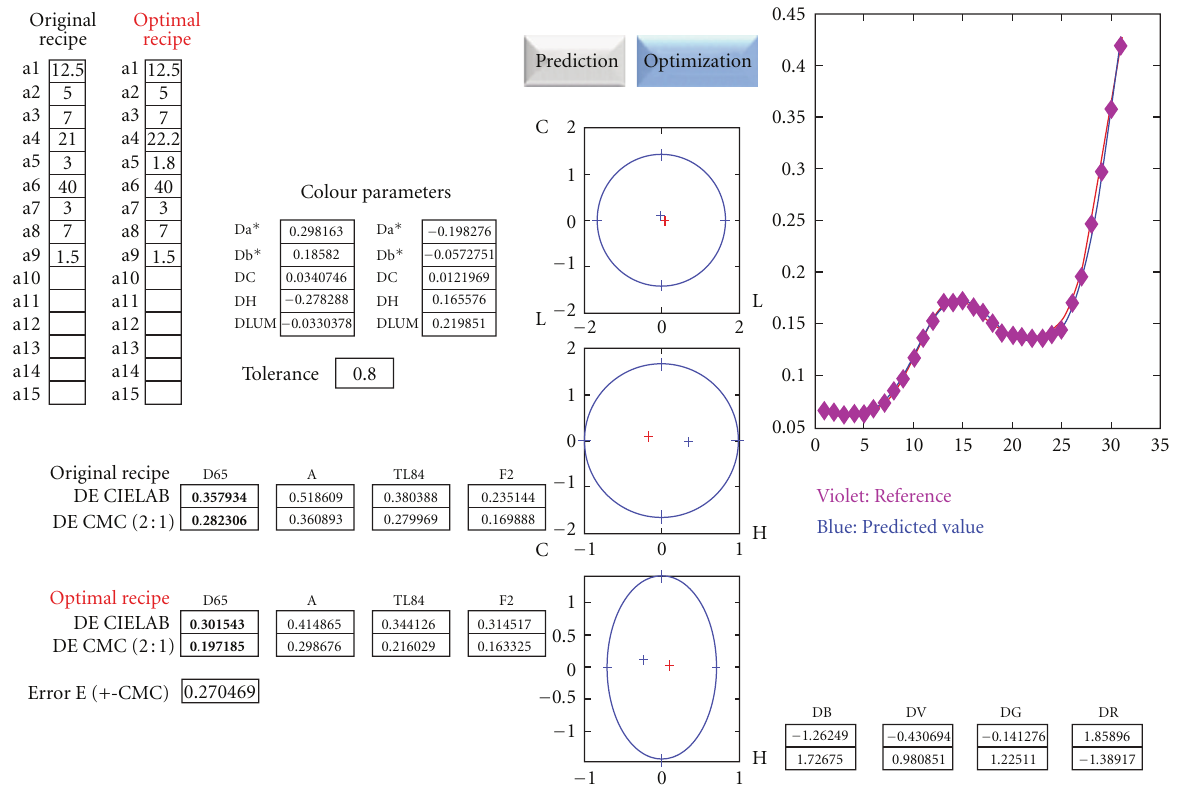
Figure 6: developed